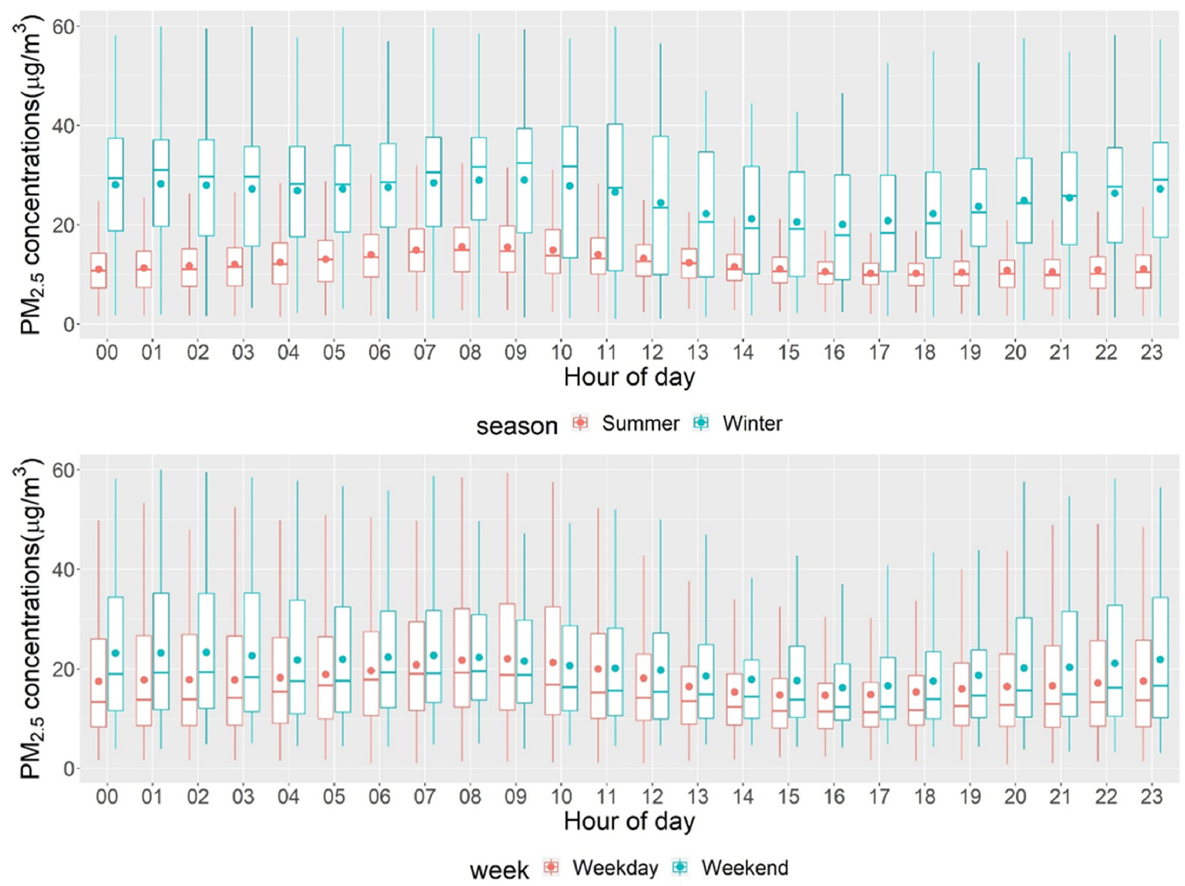
Figure 5. Boxplots of hour-of-day PM 2.5 concentrations by season and weekday/weekend. The red/blue dots indicate average concentrations. The boxes show the interquartile range (IQR). The upper whisker extends from the hinge to the largest value at most 1.5*IQR, while the lower whisker extends from the hinge to the smallest value at most 1.5*IQR.